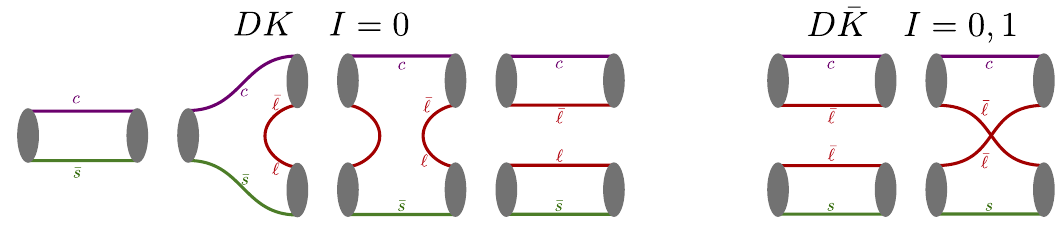
Figure 1 . A schematic representation of the types of Wick contraction topologies that contribute to isospin-0 DK and isospin-0 and 1 D ¯ K correlation functions involving D s (single-meson) and DK/ ¯ K (meson-meson) operators. The grey ellipses represent fermion-bilinear operators with var- ious structures or sums of such operators. For each irrep we compute sums of several thousand Wick contractions with these sorts of